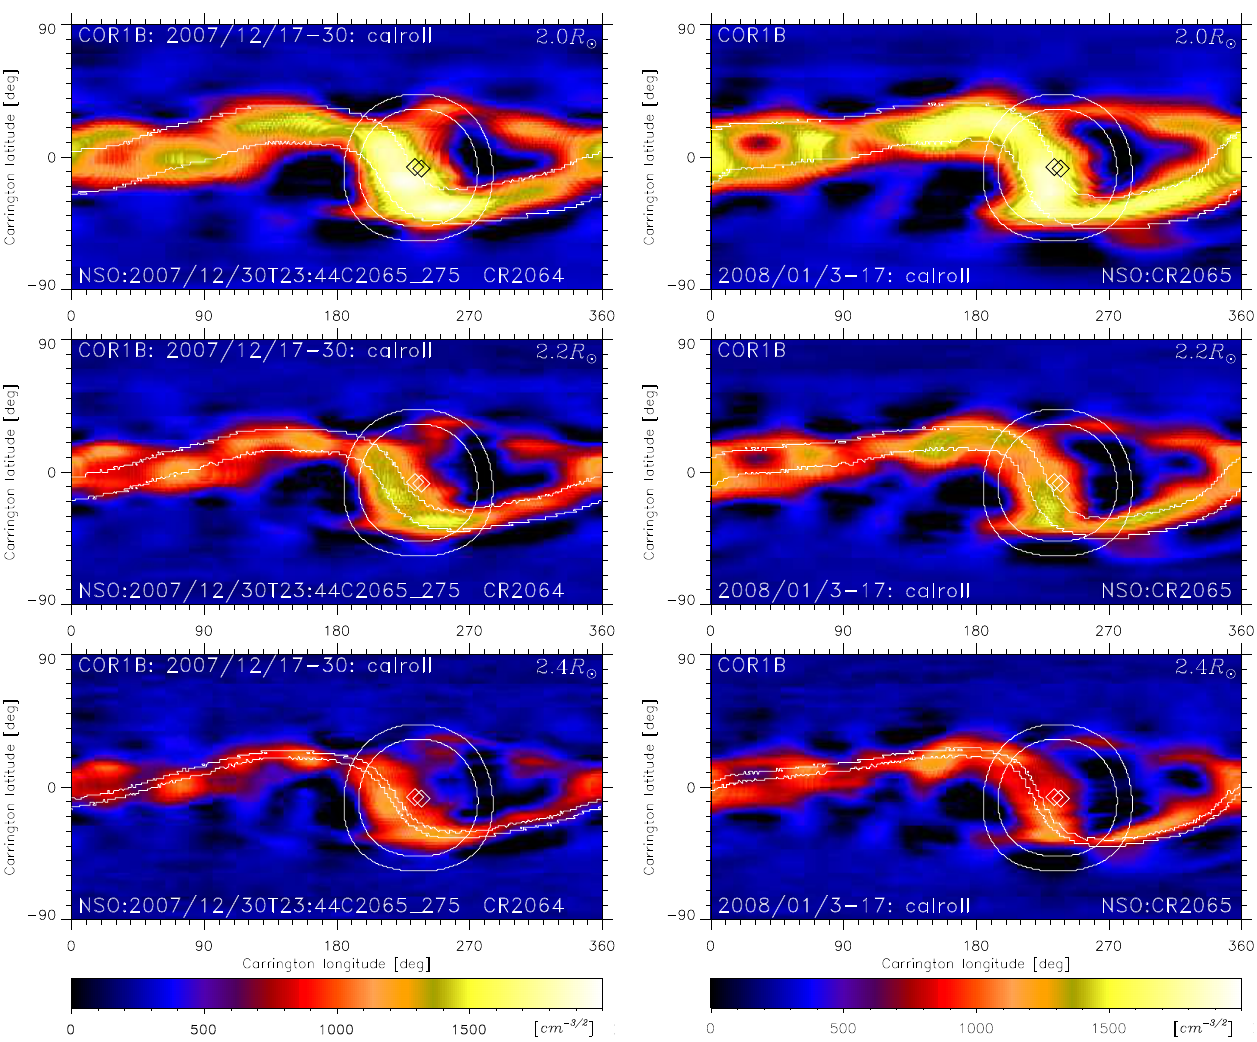
Fig. 5. Spherical cross-section of reconstructed electron density in square root scale at heliocentric distances 2 . 0 , 2 . 2 and 2 . 4 R ⊙ (the distances are shown in the right upper corners). The reconstruction for the period before CMEs of 31 December 2007 and 2 January 2008 is shown on the left panel while the reconstruction for the period after these CMEs is shown on the right panel. The white lines are the boundaries between closed and open magnetic field lines for a PFSS model with source surface at 2 . 5 R ⊙ for CR 2064 and CR 2065, i.e. periods approximately before and after the CMEs. Two rombs indicate the source regions for CME2ab. Circles shows the region used for the computation of the mass loss.